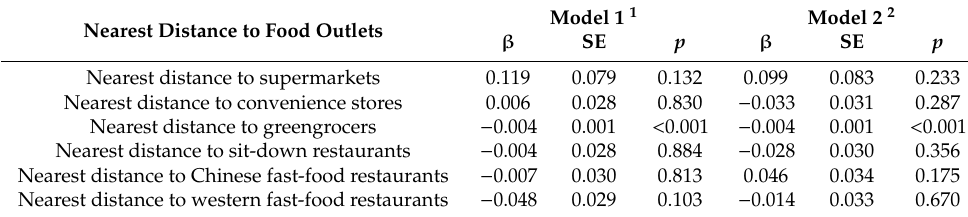
Table 5. Associations between proximity to food outlets and body mass